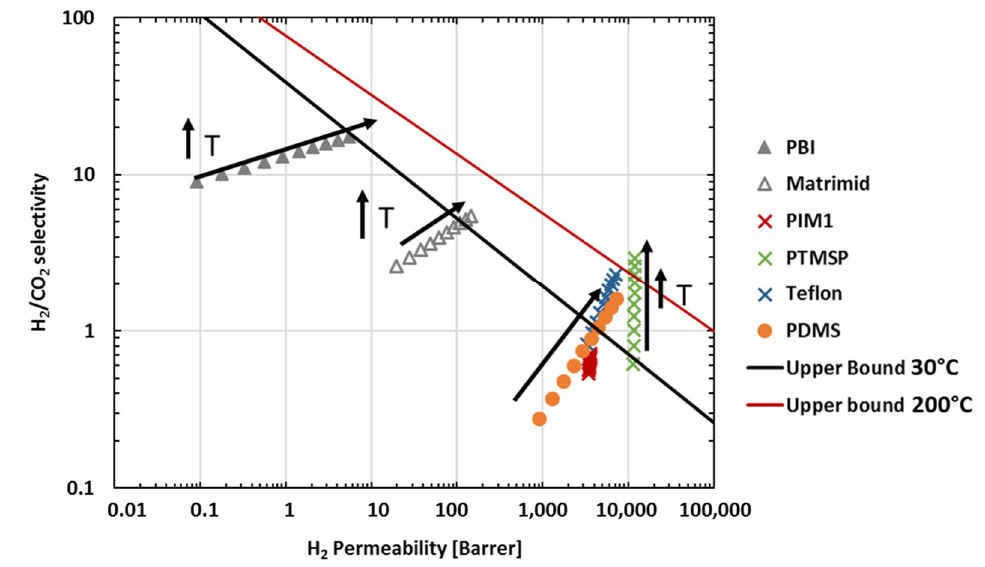
Figure 1. Influence of temperature on membrane performance (calculated from [7]) [6,8–11].